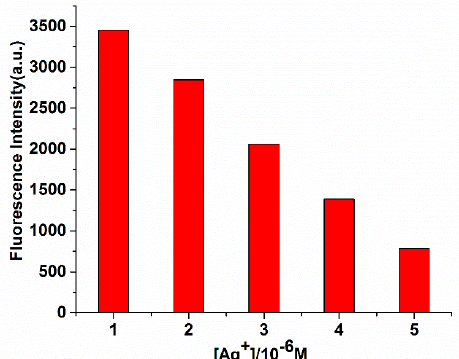
Figure 11. Fluorescence signaling of Ag + by QCy in simulated wastewater. [QCy] = 2.5 µ M, [Ag + ] = 0.0–5.0 µ M. All studies were acquired in a mixed solvent of EtOH/PBS (1/9 v / v , pH = 7.0, 10 mM). Table 1. Composition of simulated wastewater.